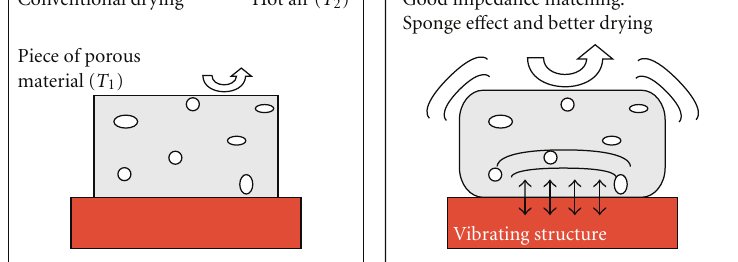
Figure 7: sponge e ff ect during vibration and drying of a porous food